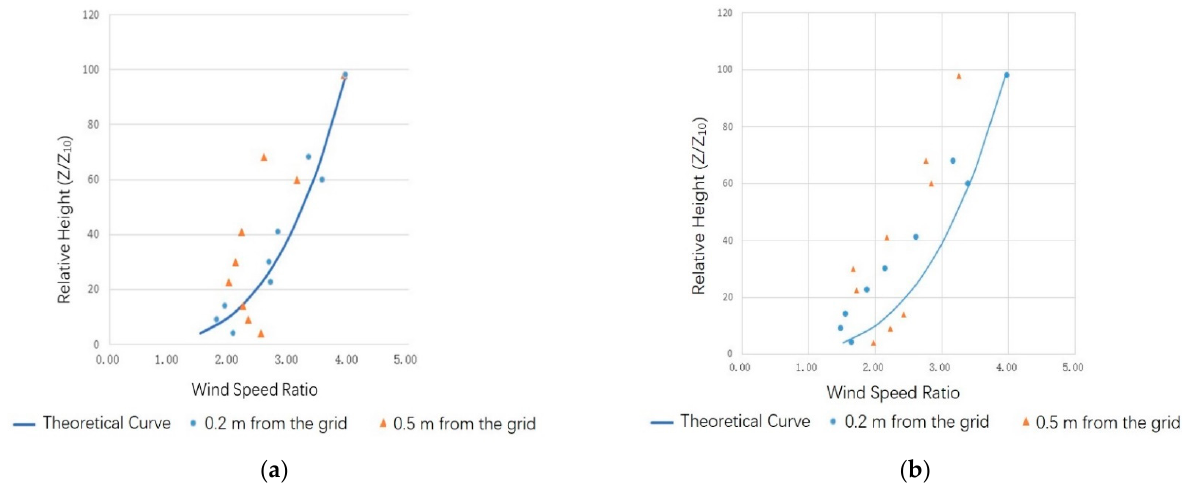
Figure 8. Comparison of the theoretical and measured wind speed ratios. ( a ) case 1; ( b ) case 2.